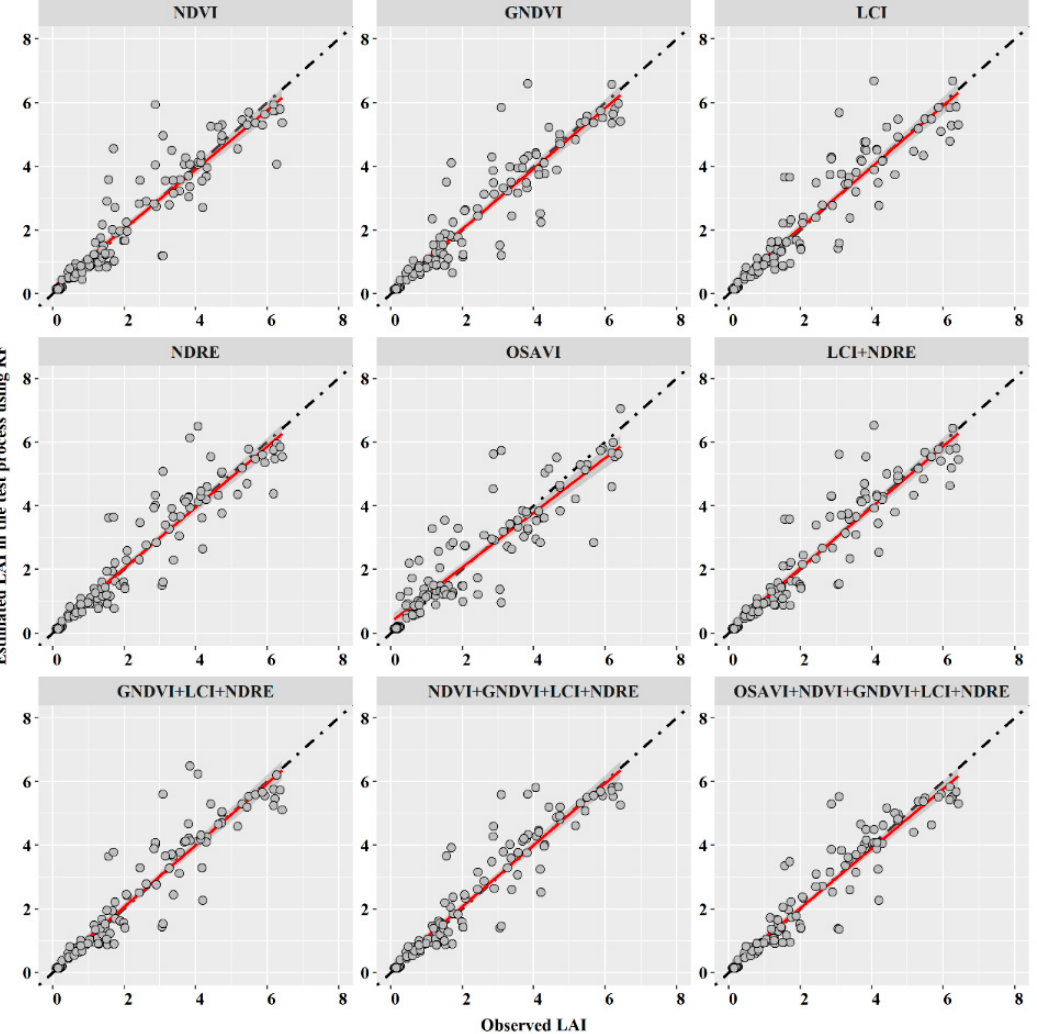
Figure 9. Relationship between observed and estimated leaf area index (LAI) of rice by random forest model (RF) with vegetation indexes (VIs) in the test process. Dash lines and red solid lines are the 1:1 lines and the linear fitting lines, respectively. The shaded areas indicate the range of 95% prediction bands. Table 3. Statistical evaluation for RF and XGBoost with vegetation indexes (VIs) as input variables.